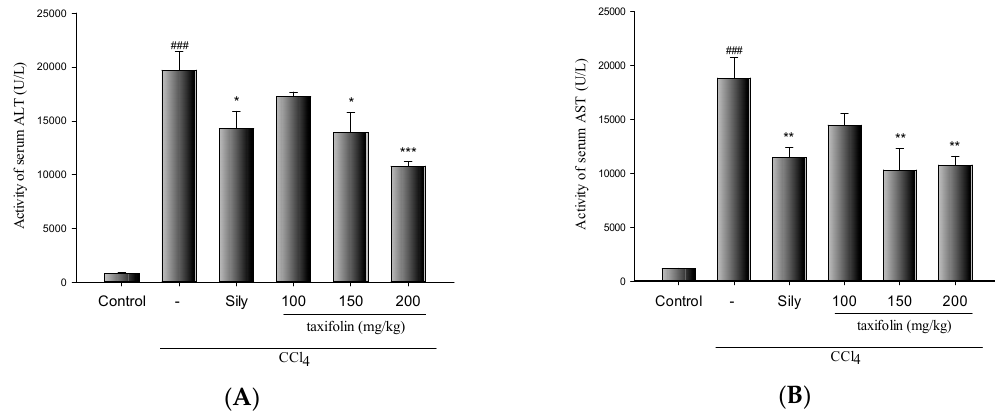
Figure 1. Effects of taxifolin and Sily on the activities of serum alanine aminotransferase (sALT) ( A ), and serum aspartate aminotransferase (sAST) ( B ) in carbon tetrachloride (CCl 4 )-treated mice; data are presented as means ± SEM ( n = 10). ### p < 0.001, compared with the control group; * p < 0.05, compared with the CCl 4 group. One-way ANOVA followed by Tukey–Kramer tests was used to identify the di ff